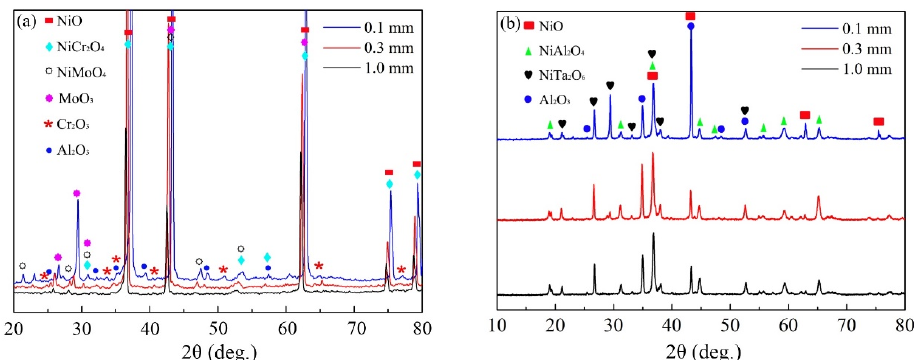
Figure 3. XRD patterns of oxides formed on the specimens of IC21 alloy with different thicknesses after 100 h of cyclic oxidation: ( a ) 900 °C; ( b ) 1100 °C.